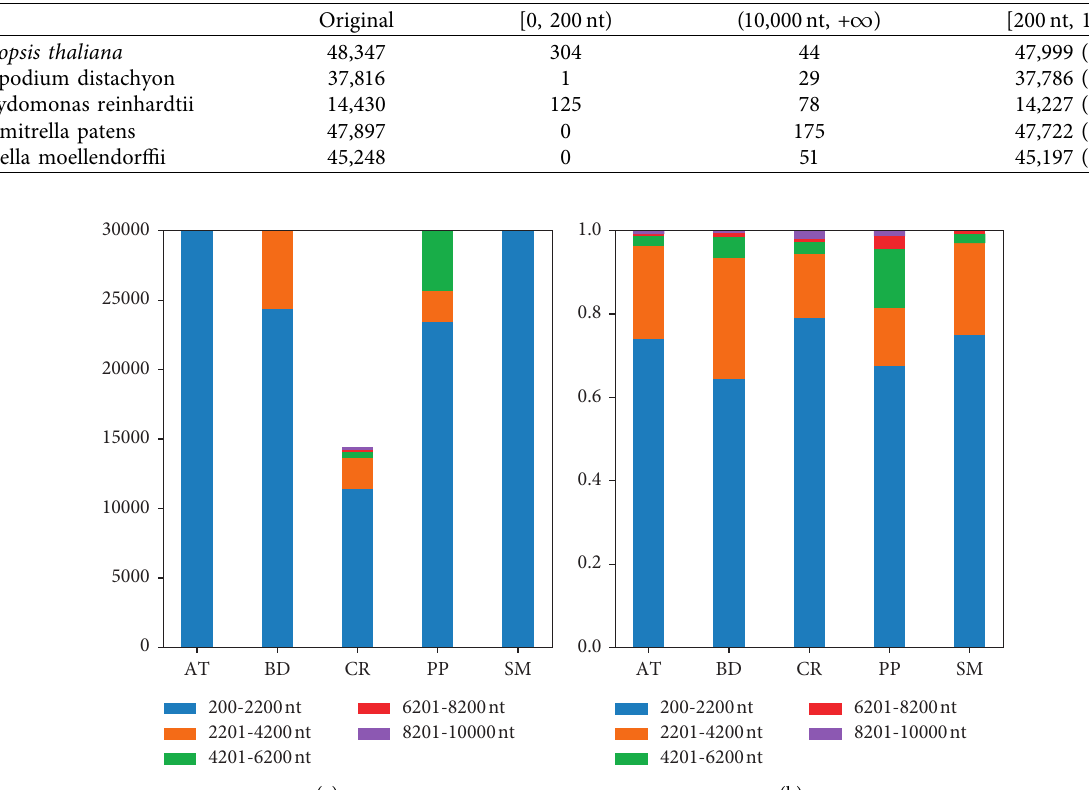
Table 1: Numeric description of mRNAs in the five plant data sets.